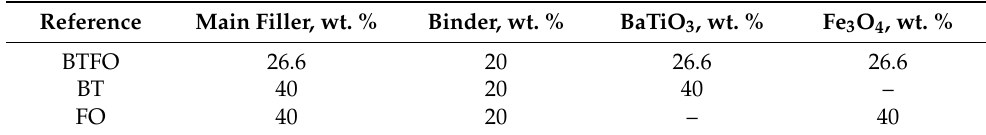
Table 1. Weight content of the components in the composite